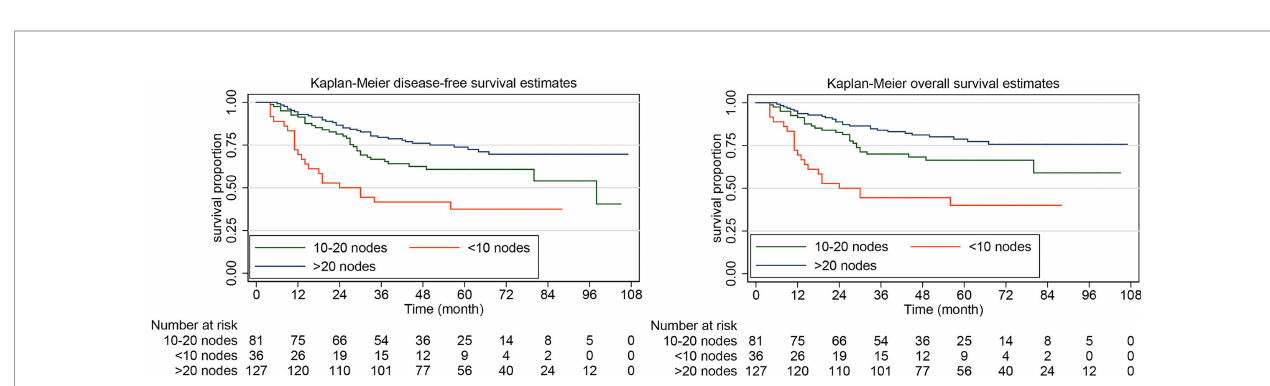
FIGURE 3 | Kaplan-Meier curves of disease-free survival and overall survival for patients with apparent early-stage clear cell carcinoma of the endometrium, by the number of the lymph nodes